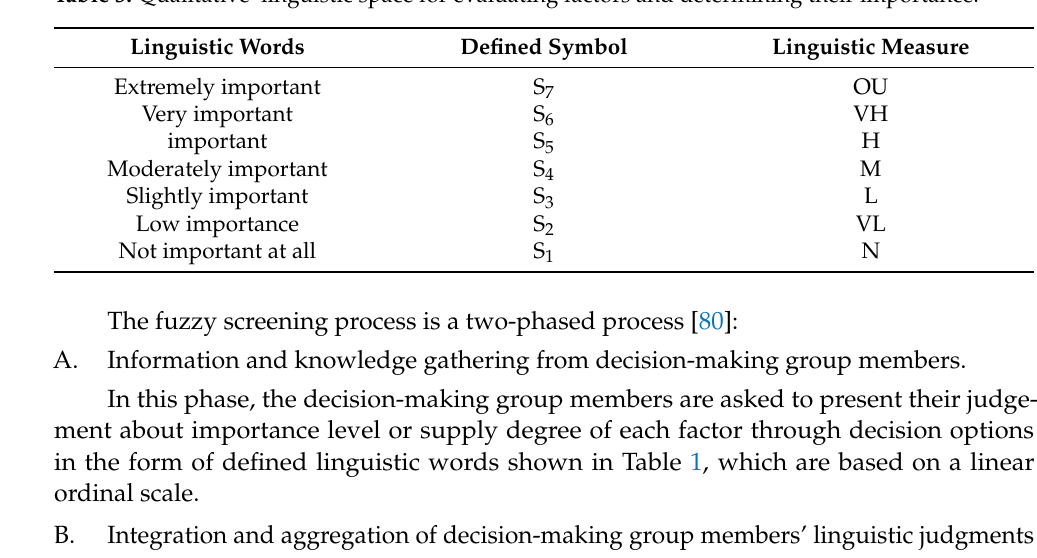
Table 3. Qualitative–linguistic space for evaluating factors and determining their